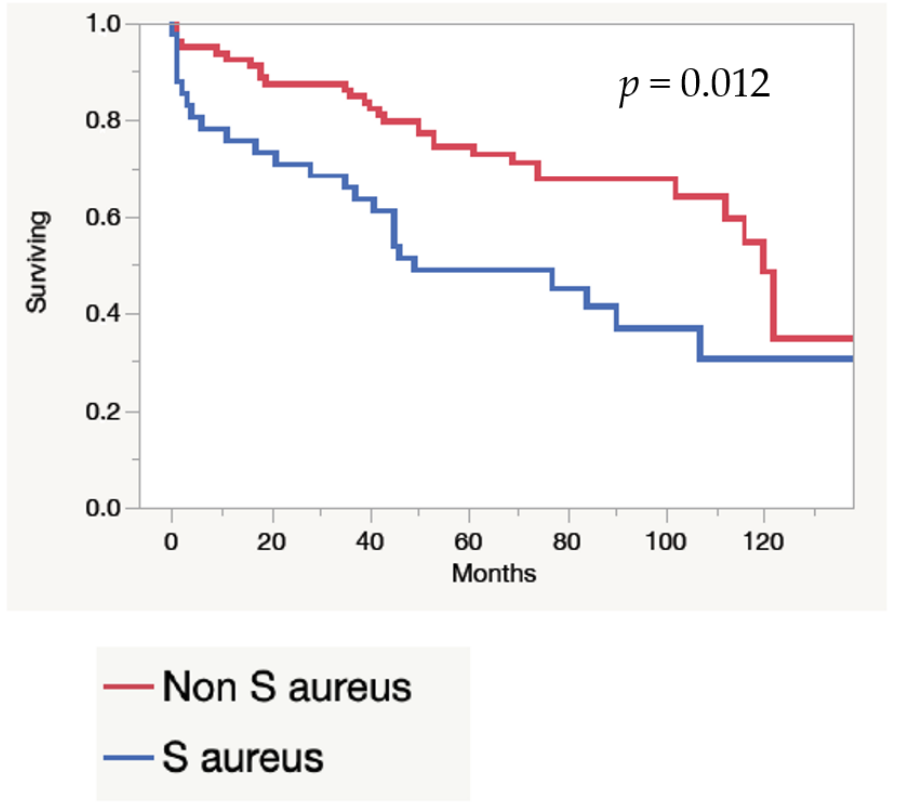
Figure 2. Long-term survival for CIED infections caused by S. aureus and non- S aureus .